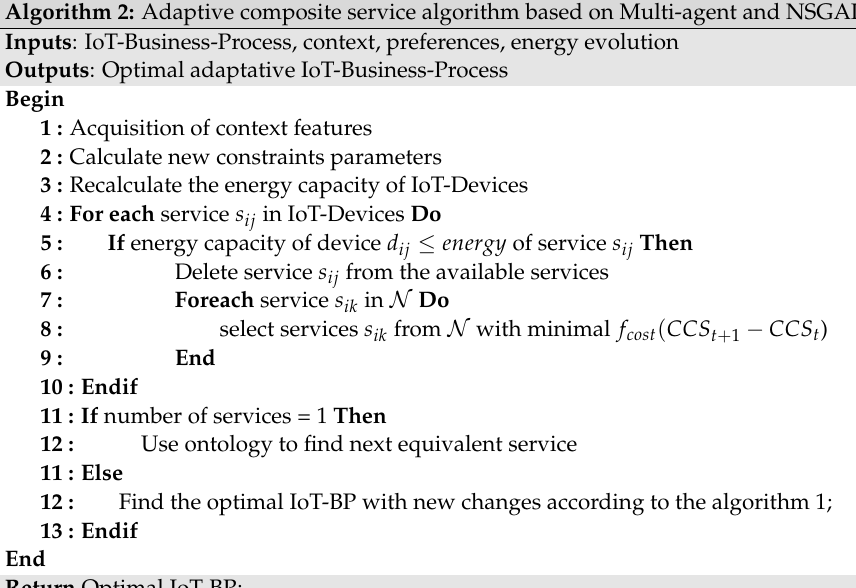
Algorithm 2: Adaptive composite service algorithm based on Multi-agent and NSGAII